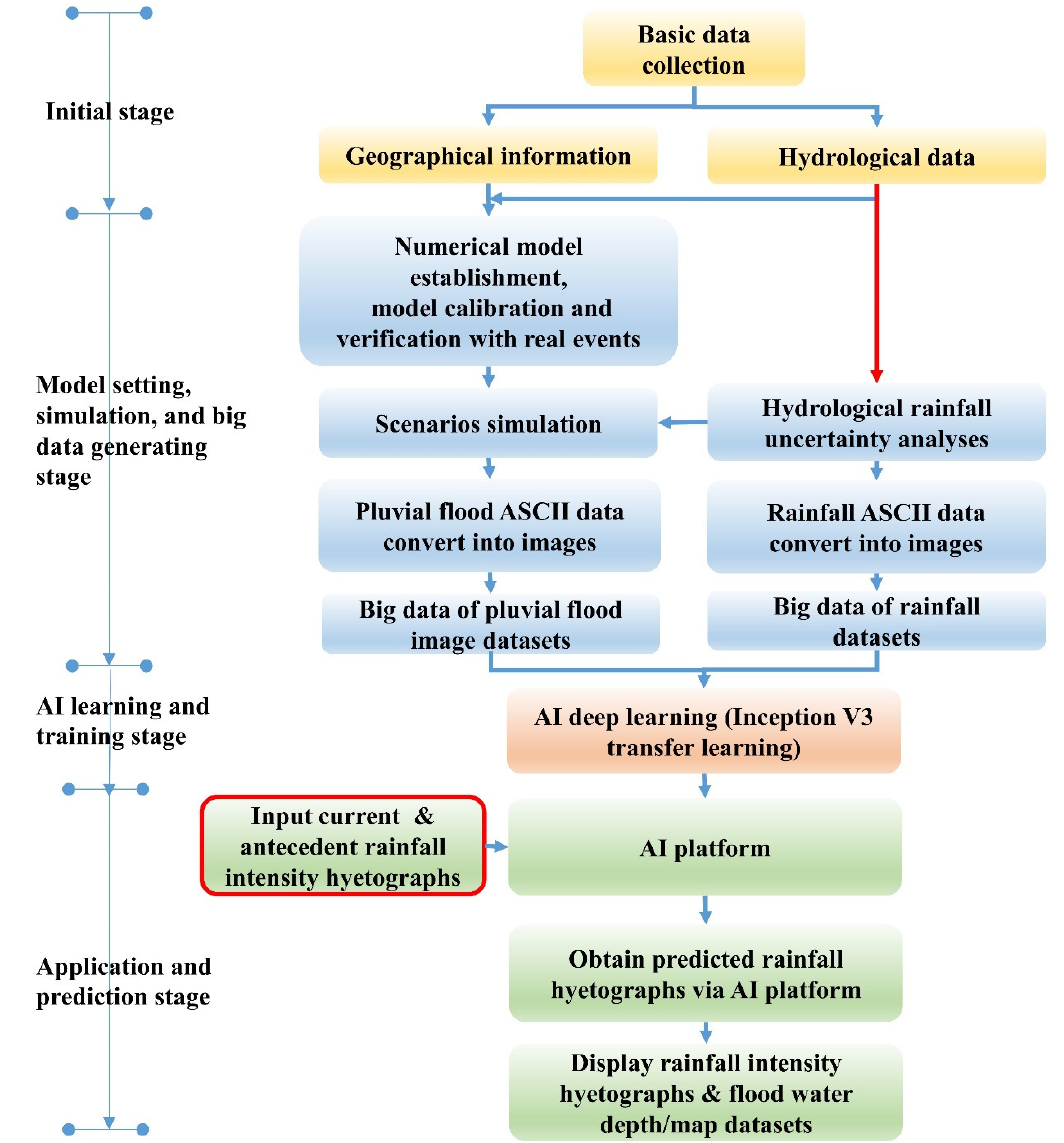
Figure 1. The analysis processes of the study.